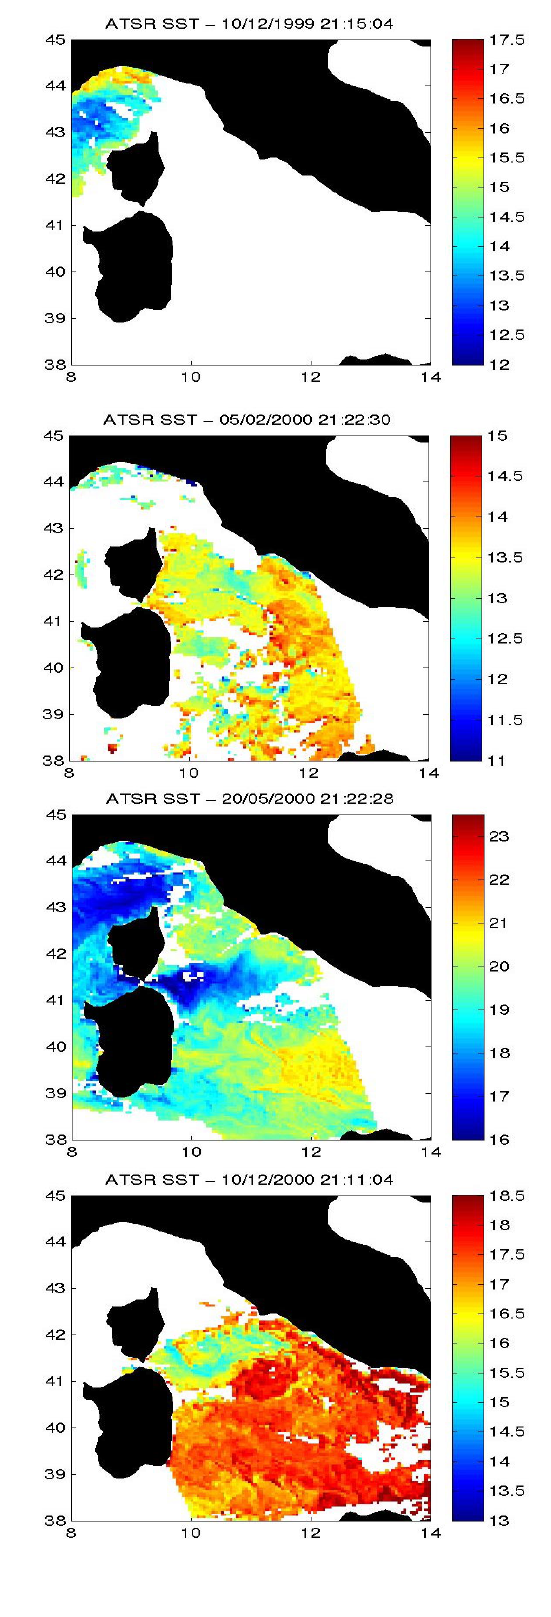
Fig. 5. Sea surface temperatures from ATSR images collected in the time frame of the XBT sections shown in Fig. 4: (a) 10–16